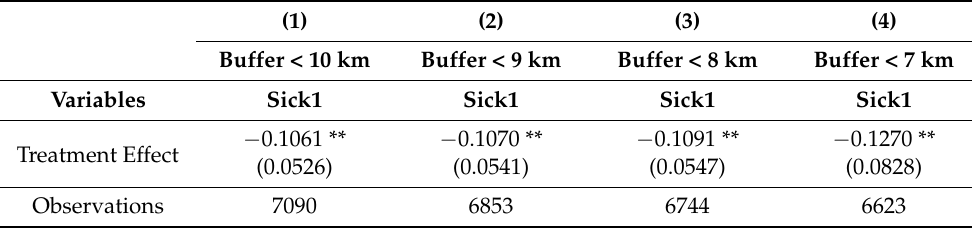
Table 4. Robustness of different buffer